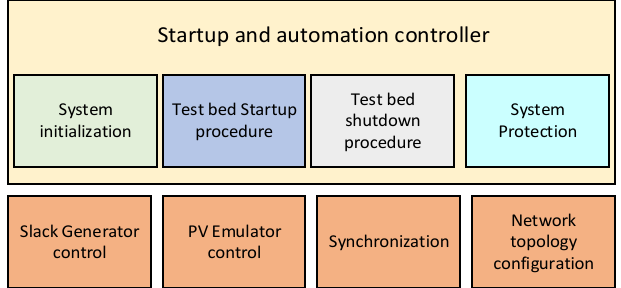
Figure 11. The hierarchy of the developed automatic controller for the smart grid testbed.